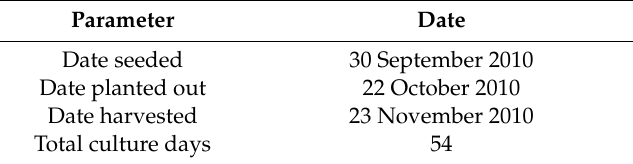
Table 3. Growth period parameters for hydroponic vs. aquaponic NFT lettuce production—spring 2010.